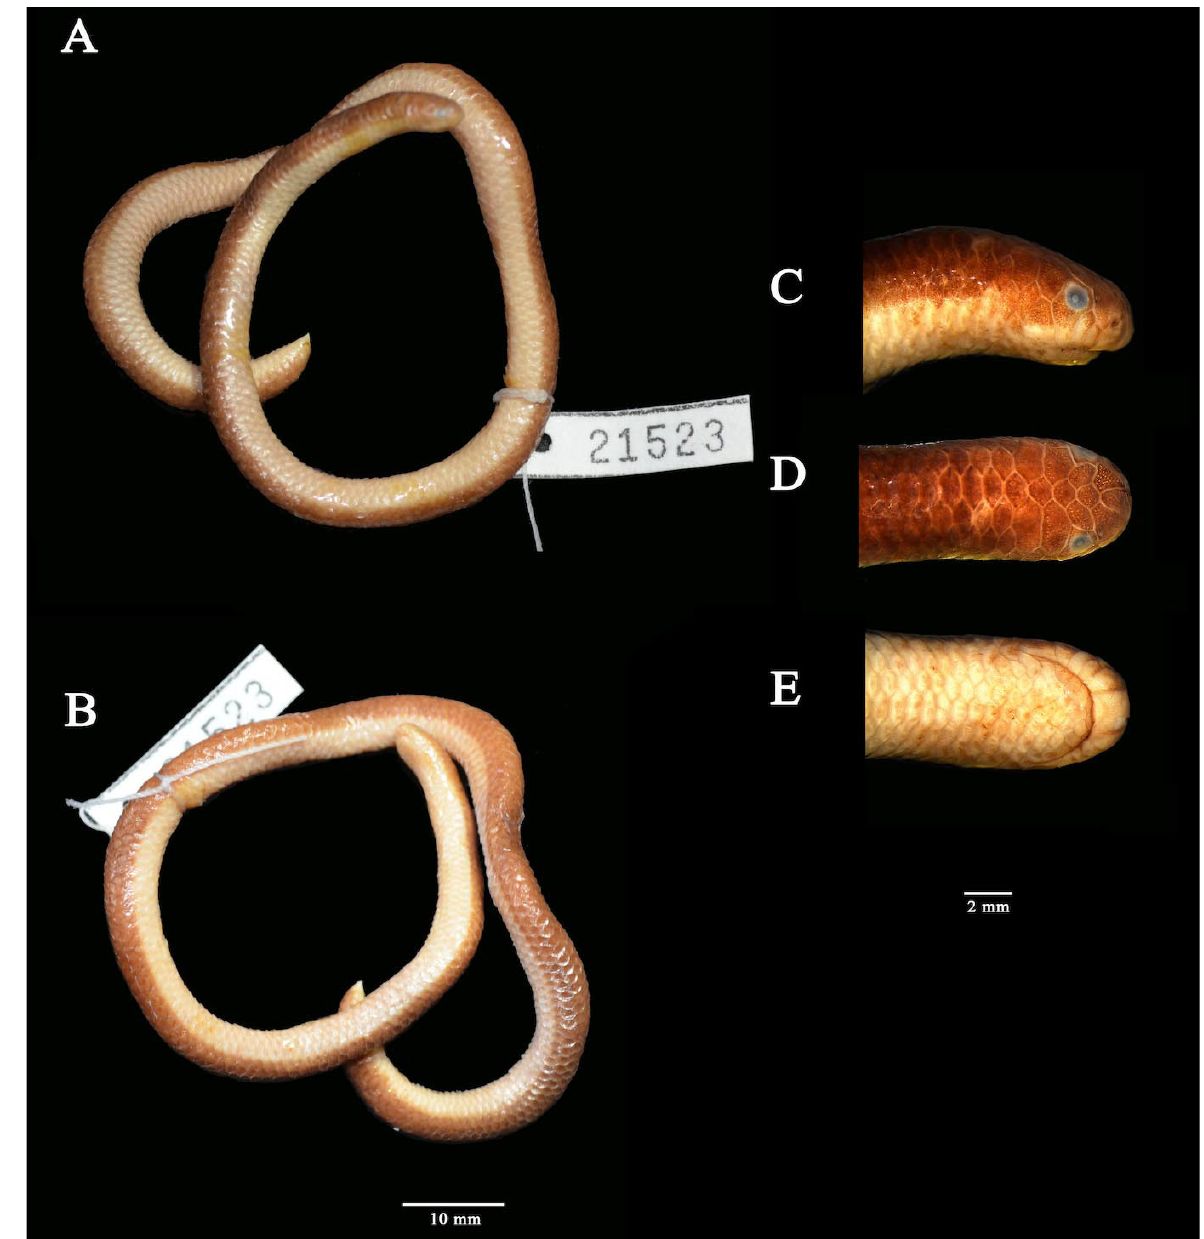
Figure 2. Trilepida fuliginosa (MPEG 21523). A . Dorsal view of the body. B . Ventral view of the body. C. Lateral head view. D. Dorsal head view. E. Gular region view. Photographs by